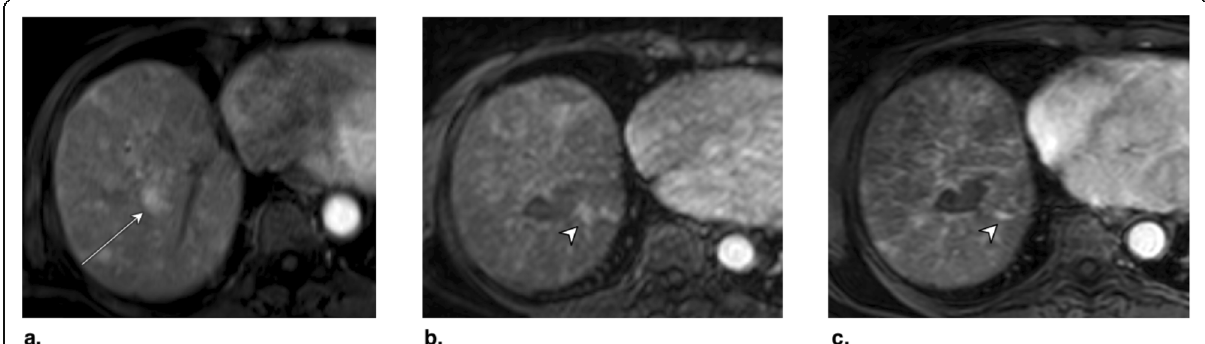
Fig. 15 Axial T1-weighted fat-saturated MR in late arterial phase obtained ( a ) pretreatment: image shows arterial phase hyperenhancement (APHE) of a 18-mm LR-5 observation (arrow). b 6 weeks post microwave ablation (MWA): image shows two nonspecific APHE perilesional nodules possibly representing perfusional changes (arrowhead). At this point, treated observation is categorized LR-TR equivocal. c 3 months post MWA: image shows disappearance of nodules in treatment zone; the treated observation is now categorized LR-TR Nonviable